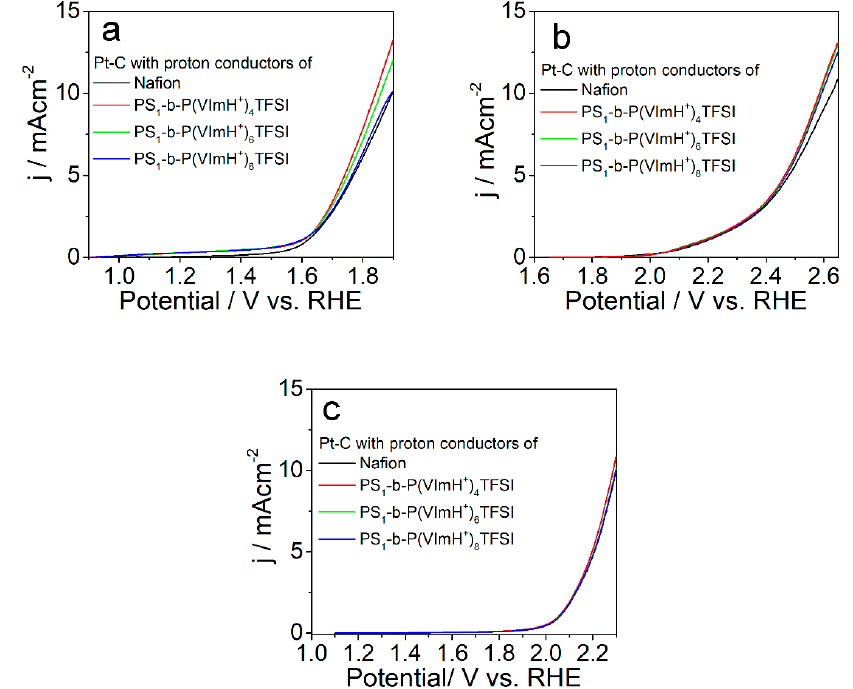
Figure 6. LSV curves of Pt-C catalyst using different ion conductors as indicated in the figures with a sweep rate of 5 mVs − 1 in ( a ) 1.0 M KOH, ( b ) PBS buffer, and ( c ) 1.0 M HClO 4 .